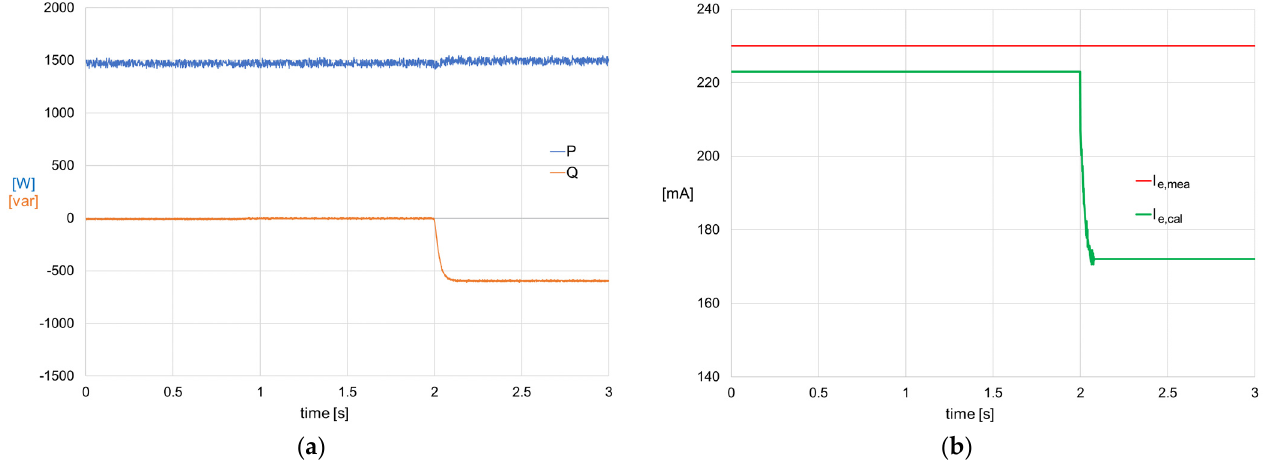
Figure 18. Healthy-to-faulty transition for a sudden open-diode fault (F1), with fixed P = 1500 W and U = 400 V: ( a ) Measured P and Q; ( b ) I e,mea and I e,cal .